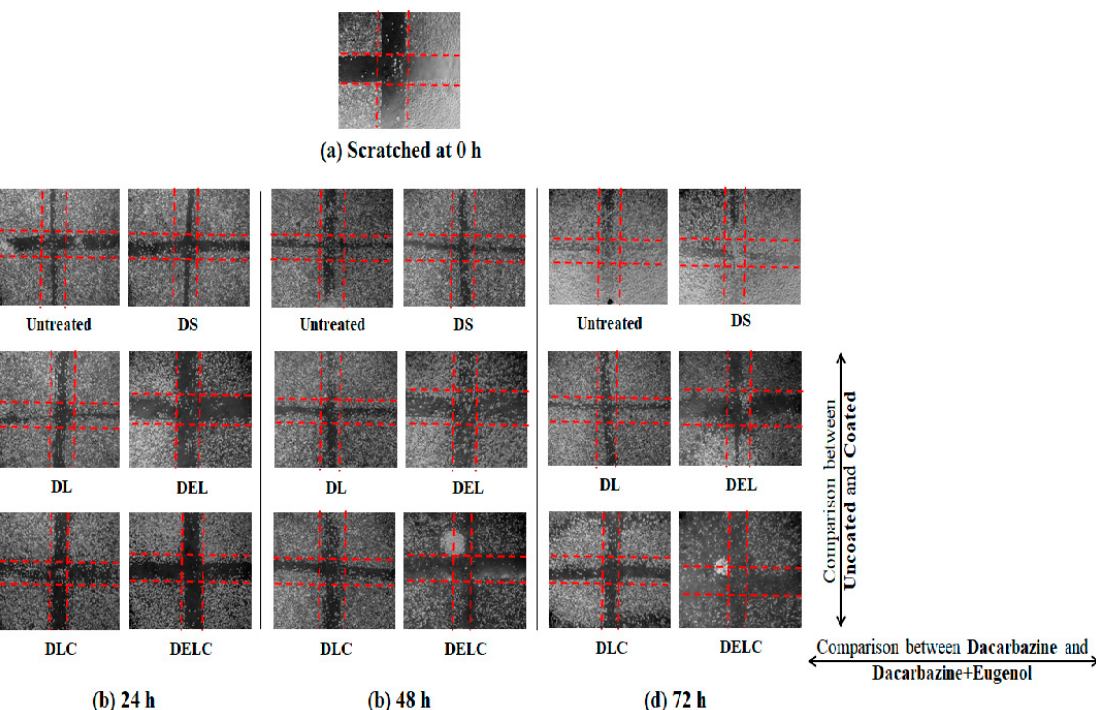
Figure 15. Migration in EA.hy926 cells.